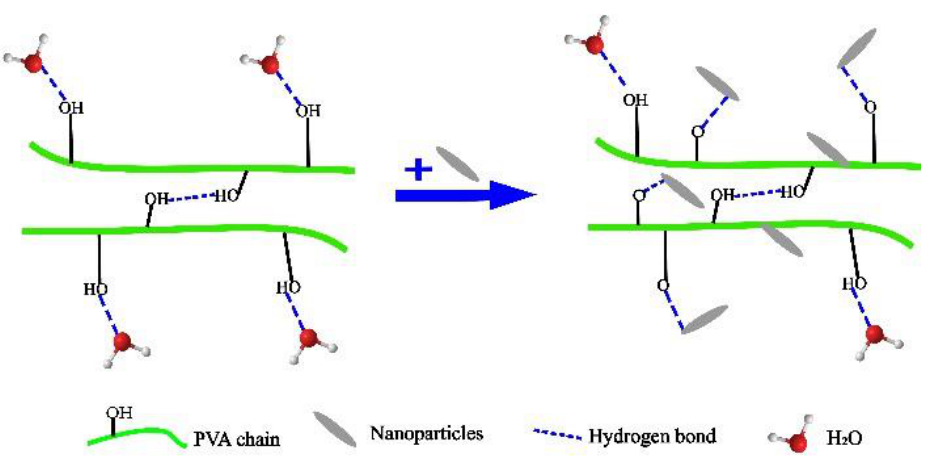
Figure 3. Diagram of nano-filling modification.